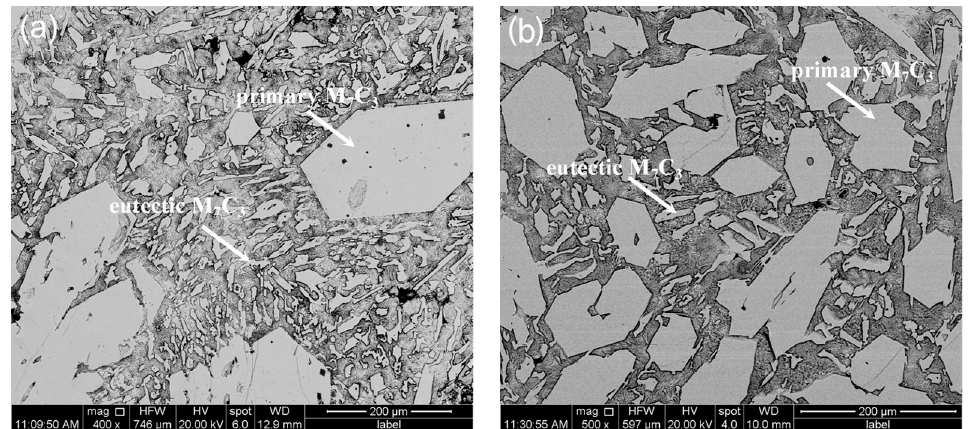
Figure 3. SEM microgrphs of Solidification microstructure of hypereutectic HCCI with or without ECP treatment: ( a ) Non-ECP treatment; ( b ) ECP treatment.